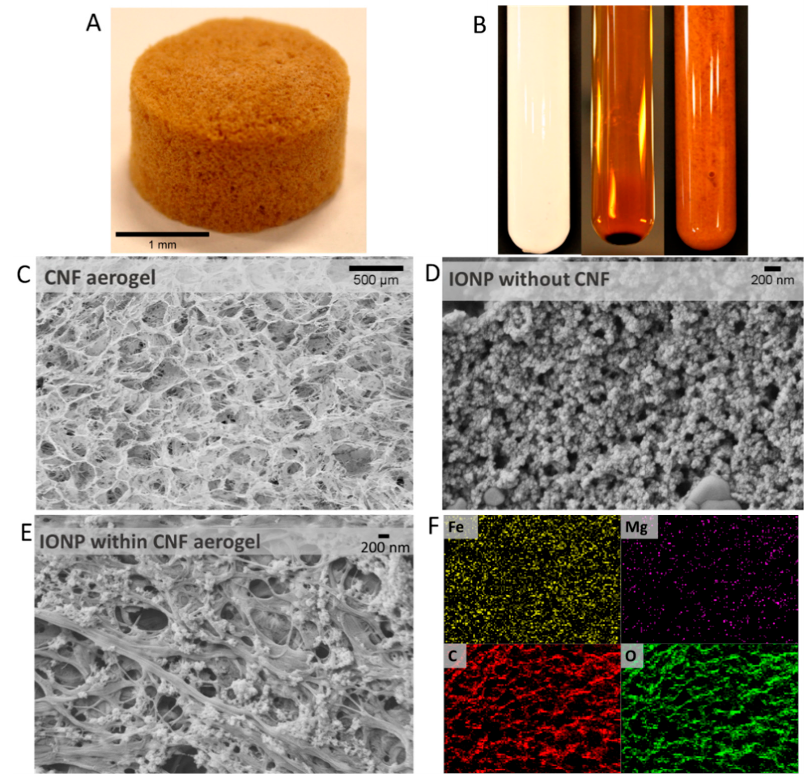
Figure 6. Photograph of CNF-IONP aerogel ( A ); from left to right: CNF suspension of 1 wt.% solids content, aggregated and precipitated IONP suspension, and IONPs immobilized on CNFs ( B ); SEM image of CNF aerogel macrostructure without IONP ( C ); SEM image of IONP ( D ); SEM image of 12.5% CNF-IONP aerogel ( E ); Corresponding EDS elemental mapping for CNF-IONP (scale bar: same as ( C )) ( F ). Note the different scales.